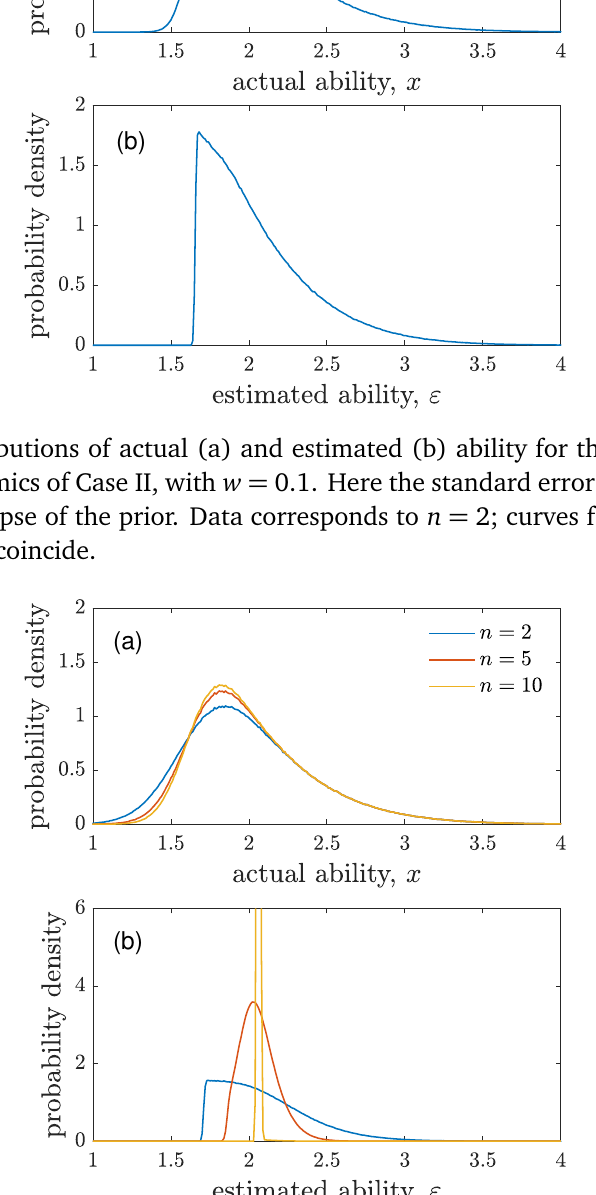
Figure 7: Distributions of actual (a) and estimated (b) ability for the prestige class under the dynamics of Case II, with w = 0.3. Here the standard error w > w causes the prior to collapse. This collapse is accompanied by a runaway narrowing in the distribution of estimated ability with increasing n , with a mean that is larger than the mean of actual